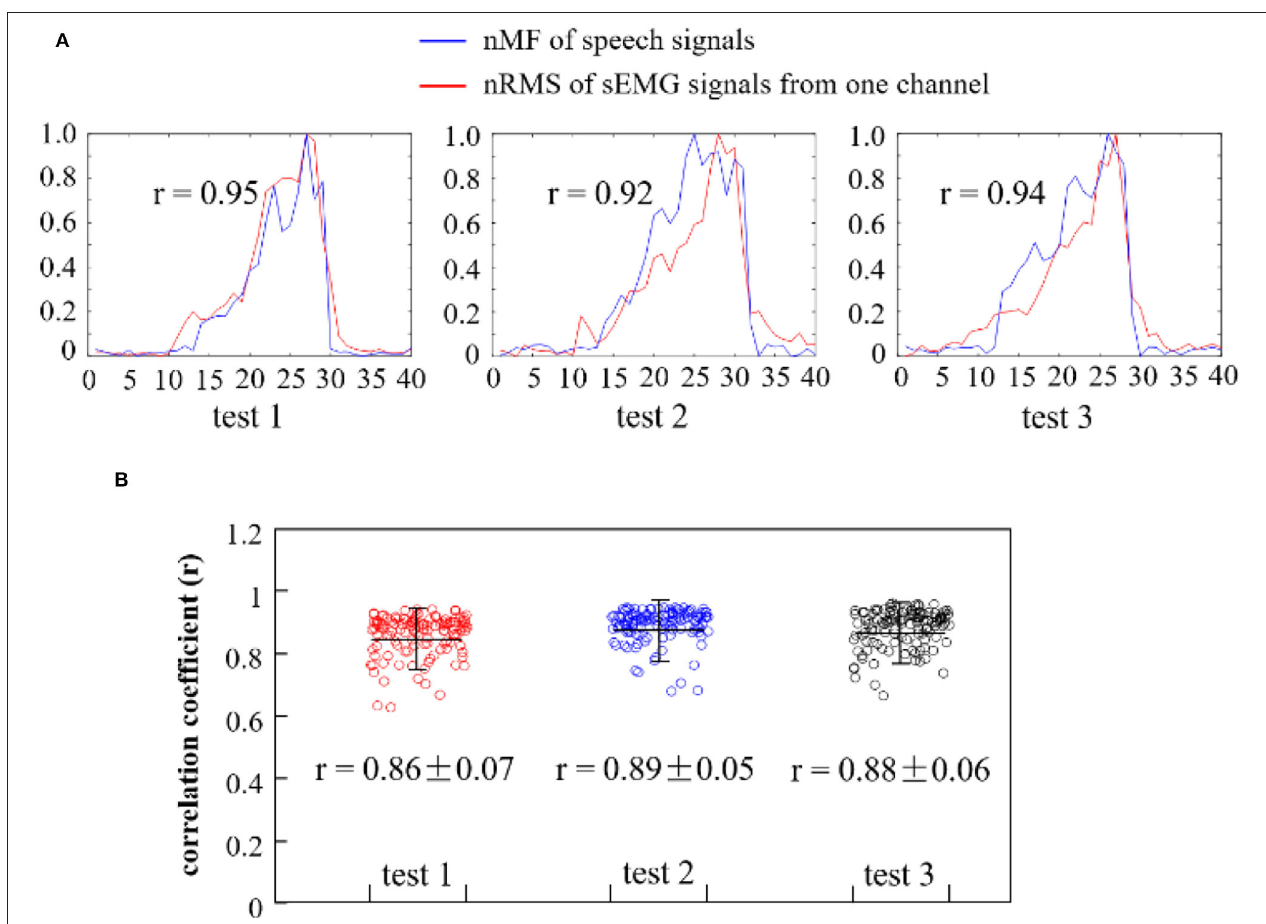
FIGURE 6 | (A) Comparison of the nMF of the speech signals and the nRMS of the sEMG recordings from one channel when phonating vowel [a:] with increasing pitch; (B) Correlation coefficients between the nRMS values of 120 channels of sEMG recordings and the nMF of the speech signal from three repeated